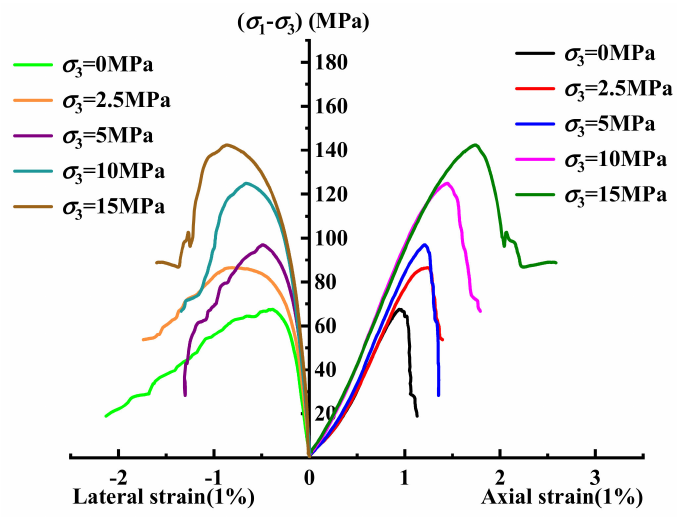
Figure 7. Stress–strain curves of sandstone samples under different confining